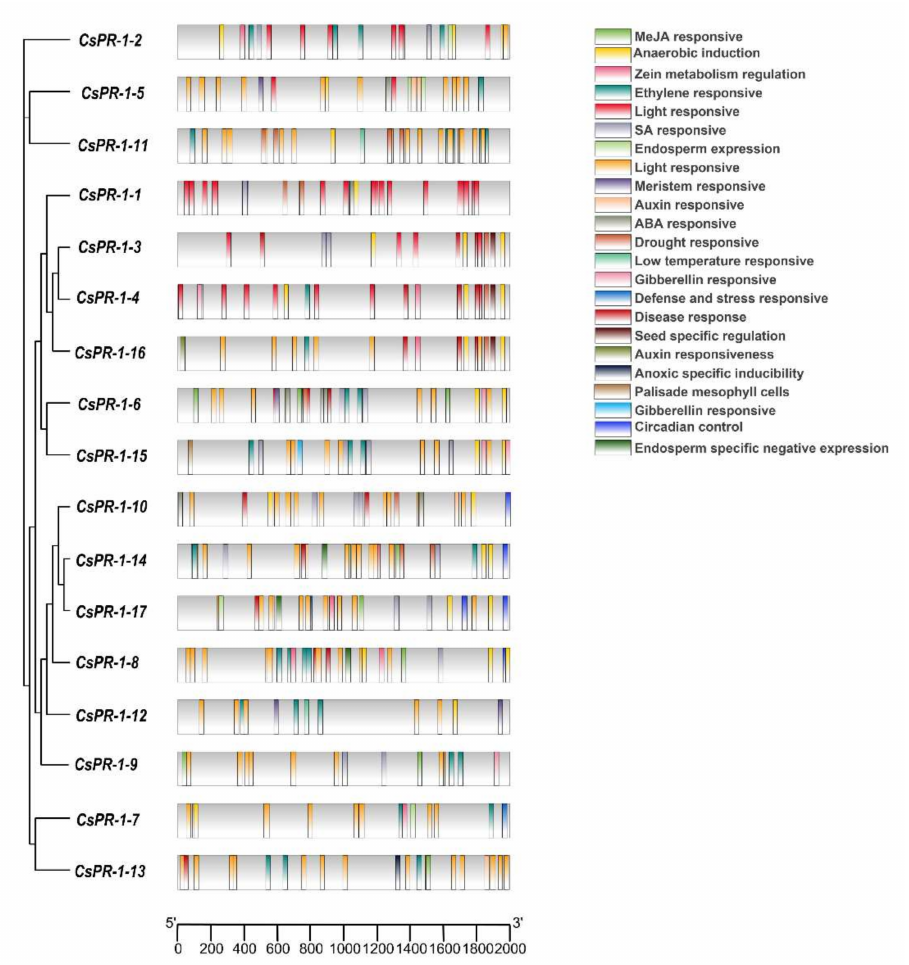
Figure 4. Schematic model of the cis elements of the CsPR-1 promoter regions generated by TBtool